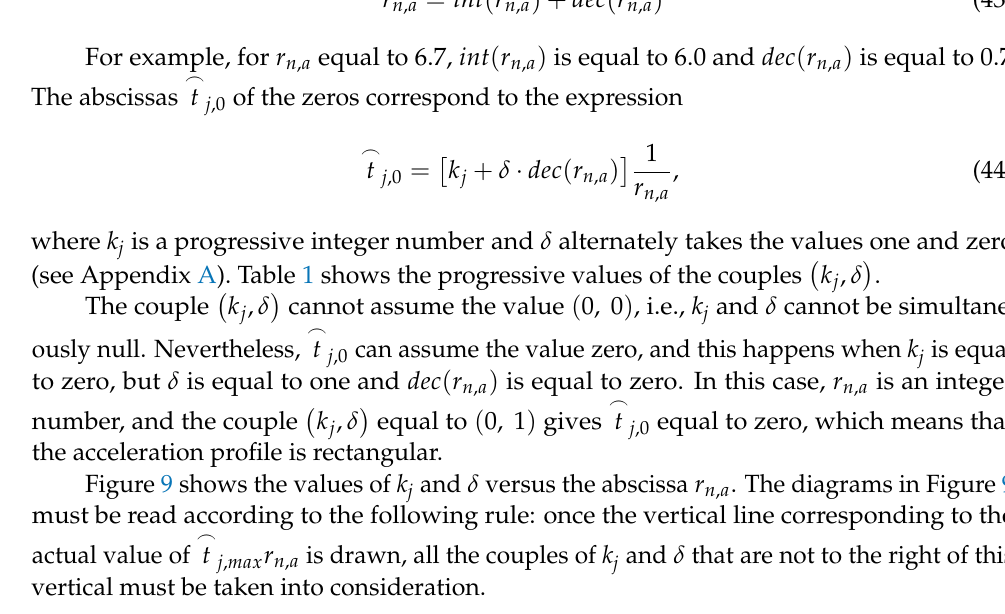
Figure 8. ( a ) Absolute value of E versus absolute value of u versus